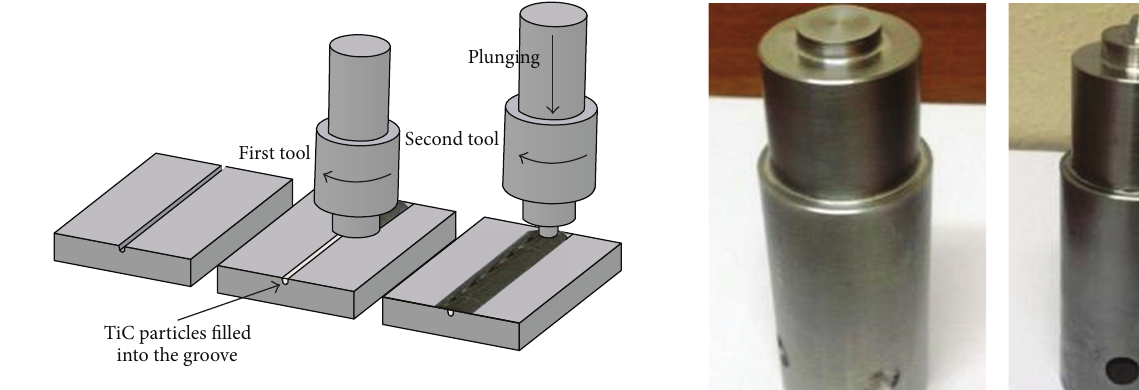
Figure 2: (a) A V-groove is machined into the base metal; (b) the substrate power is compressed using a pinless tool and (c) the composite is produced via FSP [6]. Table 1: Chemical composition of AA1050.